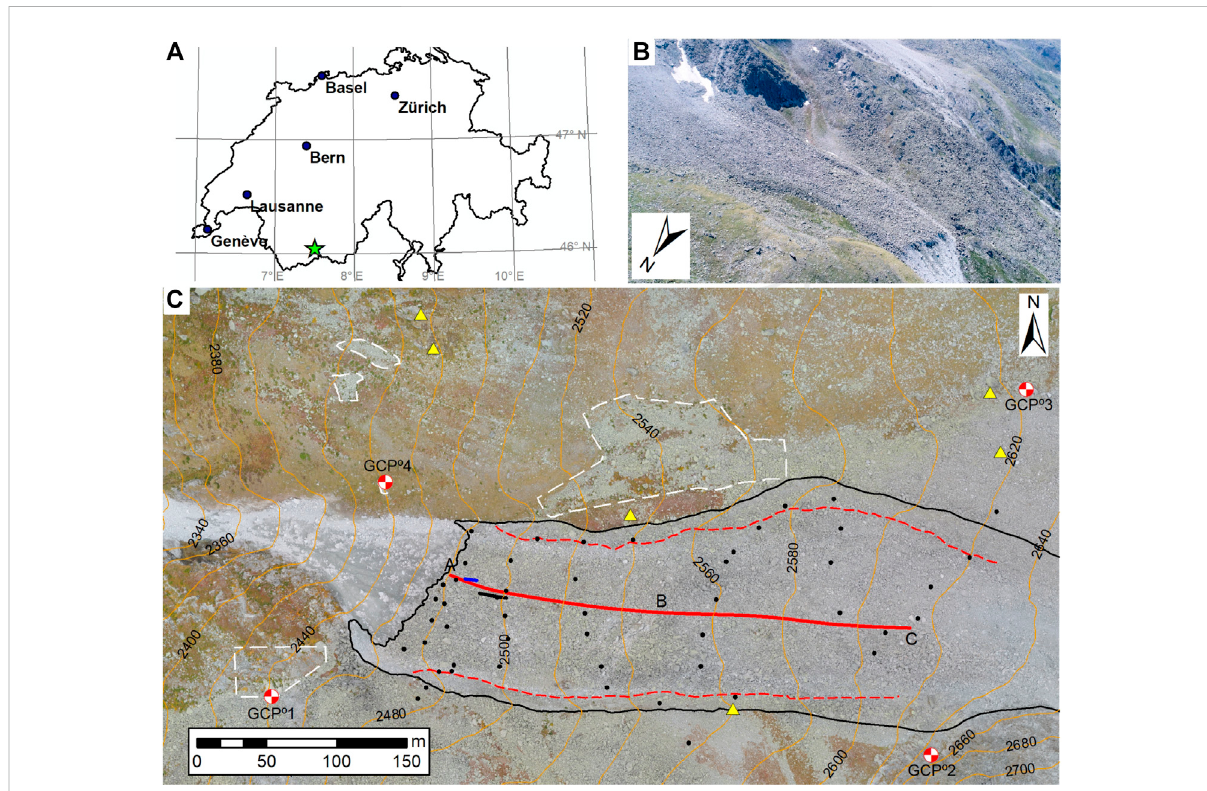
FIGURE 1 Overview of the Tsarmine rock glacier and its surveying setting. (A) Location of the rock glacier within the Western Swiss Alps (green star). (B) Oblique aerial image from Tsarmine in June 2017. (C) UAV-derived orthomosaic from September 2019. Black thin line corresponds to the rock glacier outline in 2019. White dashed areas correspond to the stable sectors without the signi fi cant vegetation used for the uncertainty evaluation during theimage matching step ( Surface Movements Derivedfrom Sequential Orthomosaics Section ). Blue and black thick lines correspond to the permanent GNSS station trajectories between 2016.01 – 2017.06 and 2017.06 – 2020.01, respectively. Red and dashed lines correspond to the location of the longitudinal velocity pro fi les (A, B, and C, Figure 5) and the lateral levees, respectively. Black dots and yellow triangles correspond to the rock glacier kinematics and TGS-CPs (stable points) network,